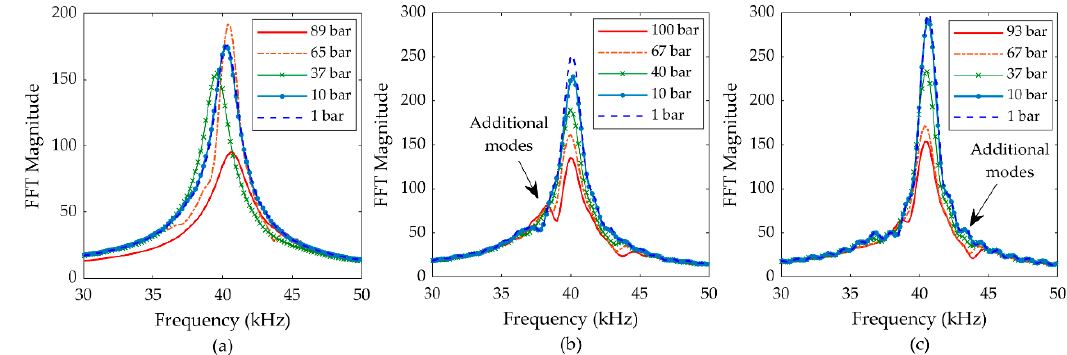
Figure 11. FFTs of the resonant ring-down decay region of the T X signals associated with the transducers at different air pressure levels ( ± 0.5 bar): (a) CFUT; (b) VFUT 1 ; (c) VFUT 2 . Note the difference in the ordinate axis scales between the CFUT and the two VFUTs.